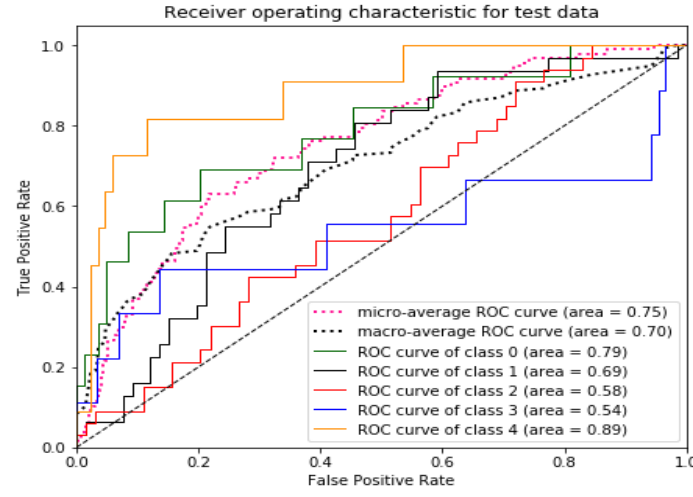
Figure 6. ROC curves for each class of test